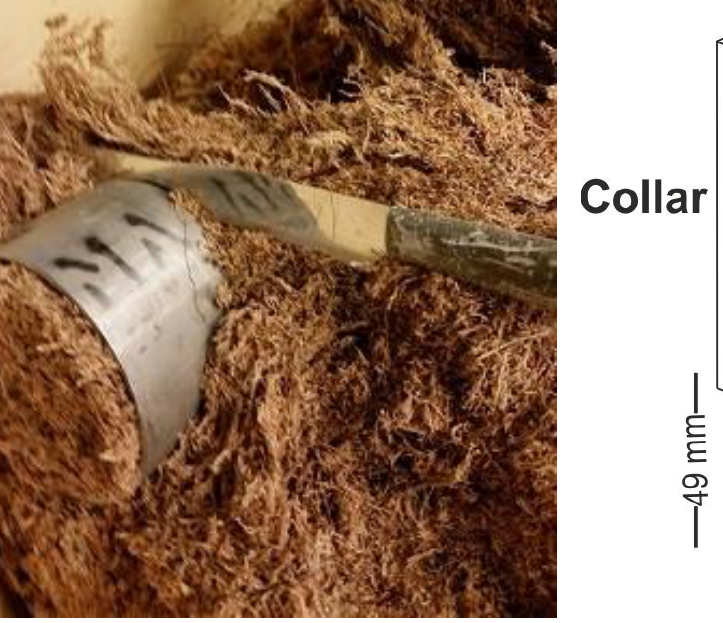
Figure 3. A schematic illustration of the cylinder, collar and piston. This set-up was used to compact Sphagnum in the soil sample cylinders to the required bulk